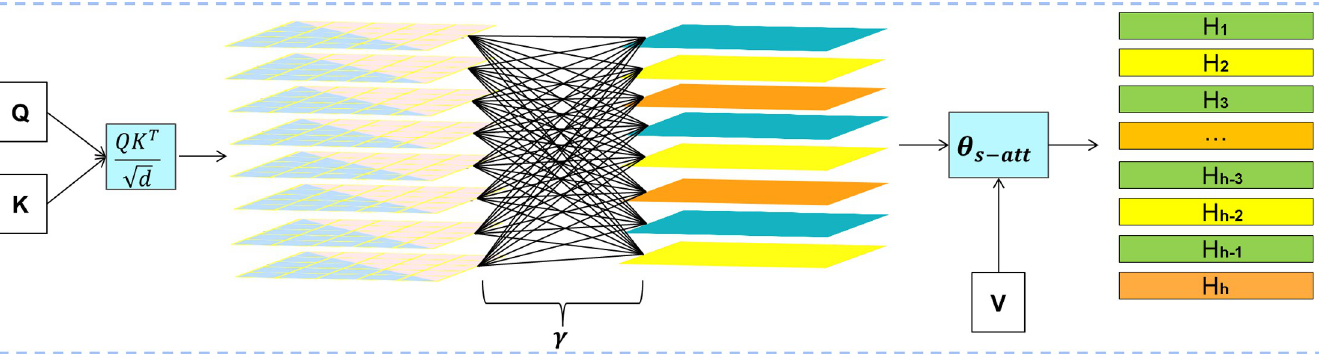
Fig 3. The hybrid multi-head self-attention